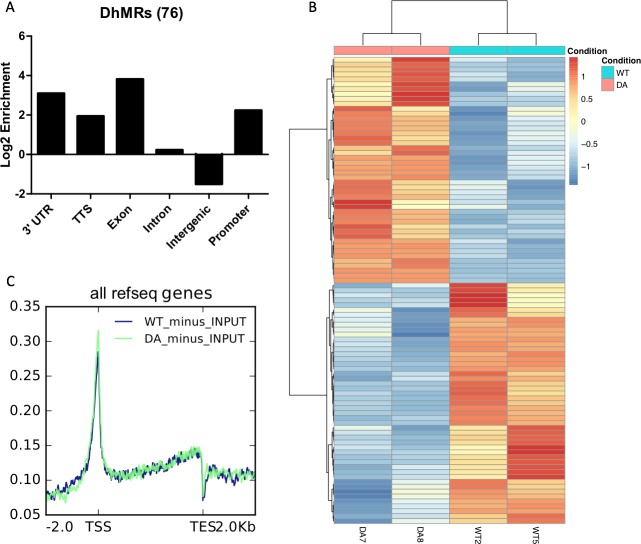
5hmC-Seal analysis of WT and D2018A mESCs.(A) Genomic annotations of differentially hydroxymethylated regions in WT vs. D2018A mESCs. (B) Heatmap depicting 95 differentially hydroxymethylated genes in WT vs. D2018A mESCs. (C) Distribution of averaged hmCpG level at all genes.